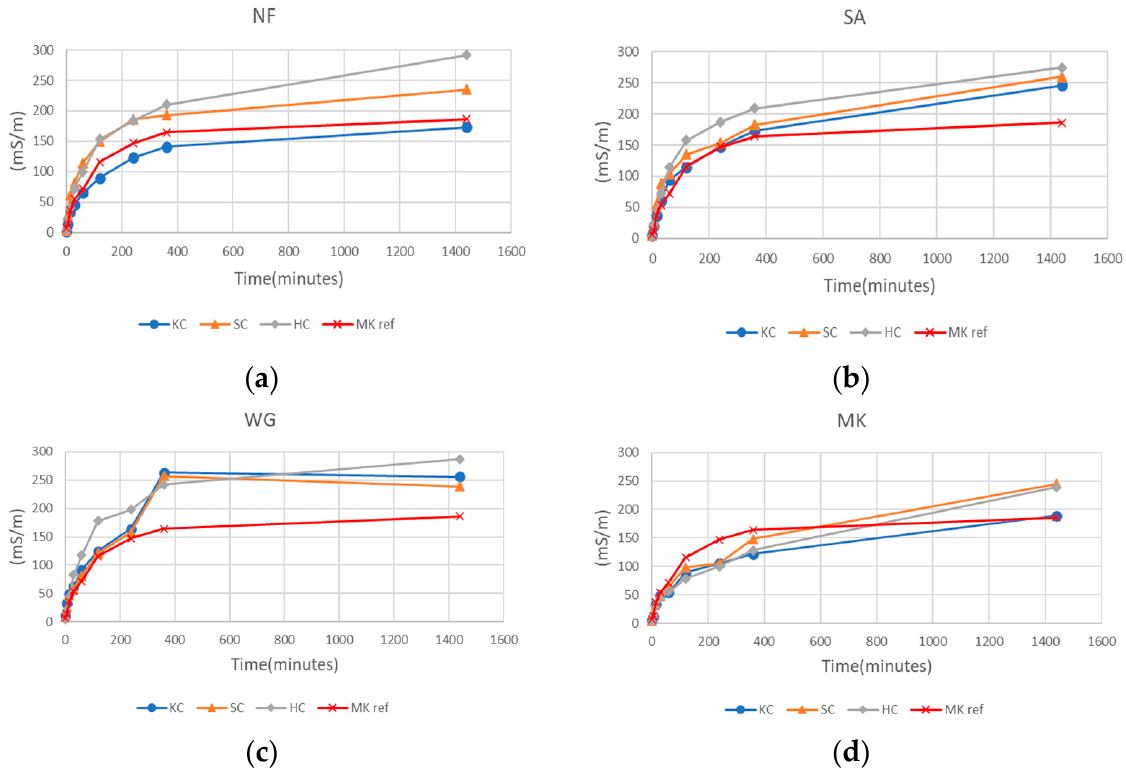
Figure 3. Ionic conductivity results of samples made with 100% clay ( a ), samples with clay and addition of sand ( b ), clay and waste glass ( c ), and clay with addition of metakaolin ( d ).